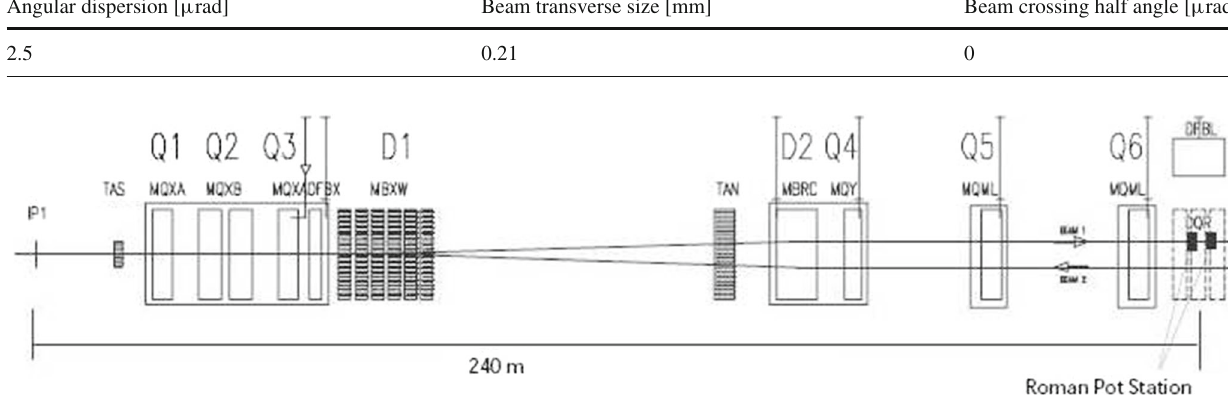
Table 1 The beam parameters at the ATLAS interaction point: the angular dispersion, the beam transverse size at the detector location and the crossing angle for the collision optics for the beam energy E beam = 6500 GeV Angular dispersion [ µ rad]